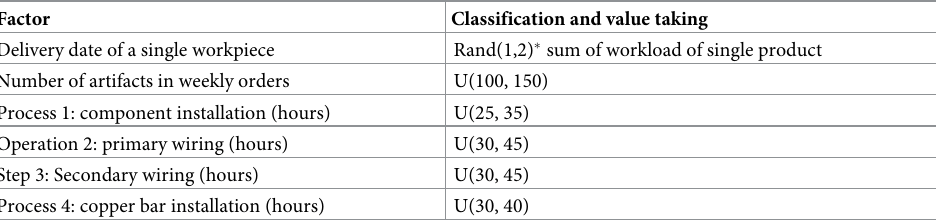
Table 2. Rules of weekly order table. Factor Classification and value